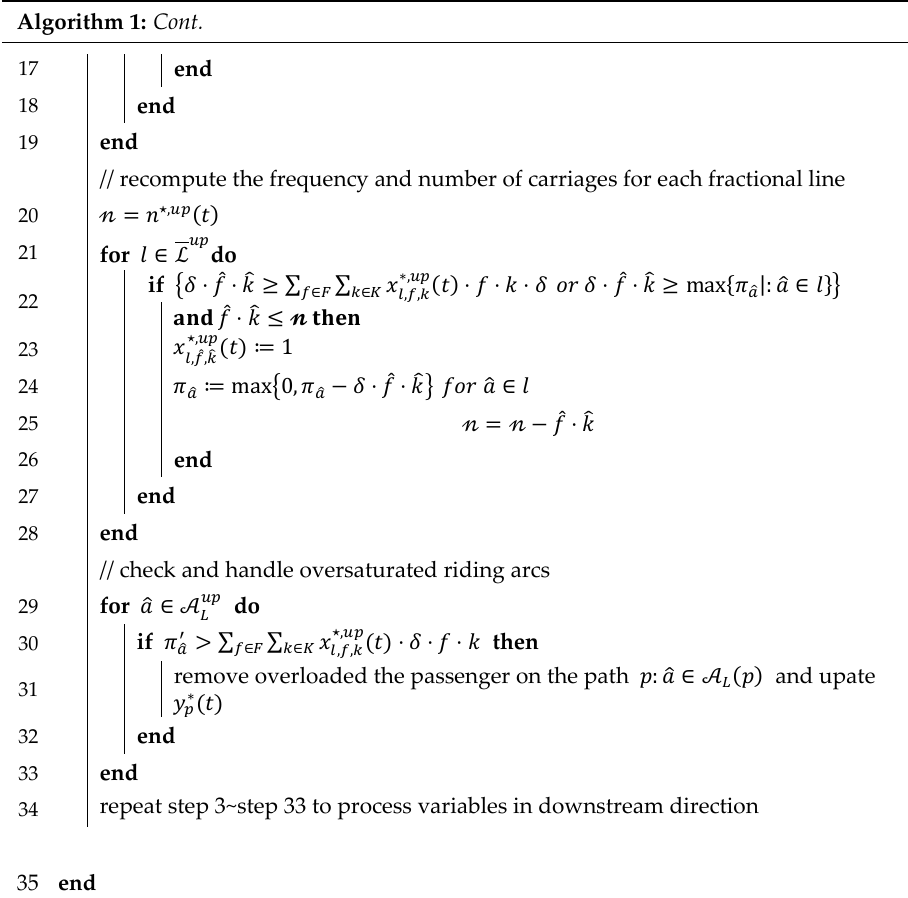
8 of 18 Algorithm 1: The improved round heuristic algorithm. Input : LP solution (𝑥 ∗,(cid:3048)(cid:3043) ,𝑥 ∗,(cid:3048)(cid:3043) ,𝑦 ∗ ,𝑛 ∗,(cid:3048)(cid:3043) ,𝑛 ∗,(cid:3031)(cid:3042)(cid:3050)(cid:3041) ) Output : IP solution (𝑥 ⋆,(cid:3048)(cid:3043) ,𝑥 ⋆,(cid:3048)(cid:3043) ,𝑦 ⋆ ,𝑛 ⋆,(cid:3048)(cid:3043) ,𝑛 ⋆,(cid:3031)(cid:3042)(cid:3050)(cid:3041) ) 1 set 𝑛 ⋆,(cid:3031)(cid:3042)(cid:3050)(cid:3041) (𝑡 = 1) = 𝑟𝑜𝑢𝑛𝑑(cid:3435)𝑛 ∗,(cid:3031)(cid:3042)(cid:3050)(cid:3041) (𝑡 = 1)(cid:3439),𝑛 ⋆,(cid:3048)(cid:3043) (𝑡 = 1) = 𝑟𝑜𝑢𝑛𝑑(cid:3435)𝑛 ∗,(cid:3048)(cid:3043) (𝑡 = 1)(cid:3439) 2